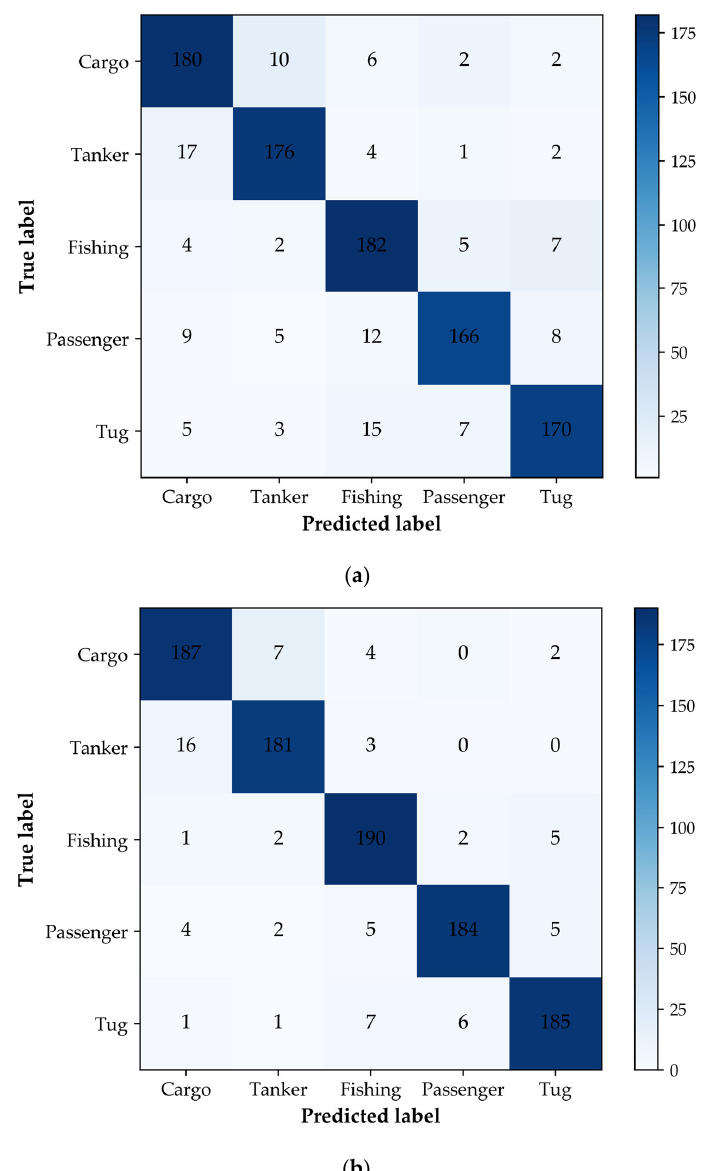
Figure 5. The confusion matrix of the five types of ship test samples considering the geometric features and behavior characteristics. ( a ) The confusion matrix of the SVM; ( b ) the confusion matrix of the RF.